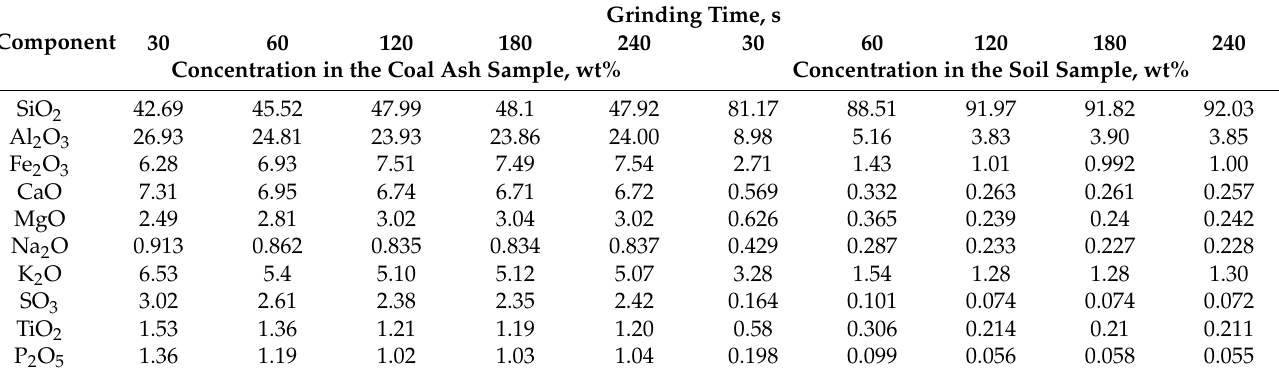
Table 1. Effect of grinding time on X-ray fluorescence analysis